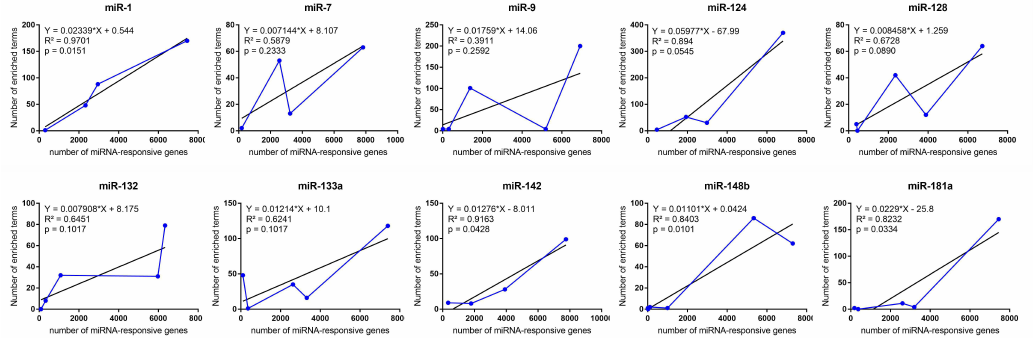
Figure 1. Correlation between the number of enriched terms and the number of miRNA-responsive genes in each cluster. Clusters are ordered according to the number of gene members